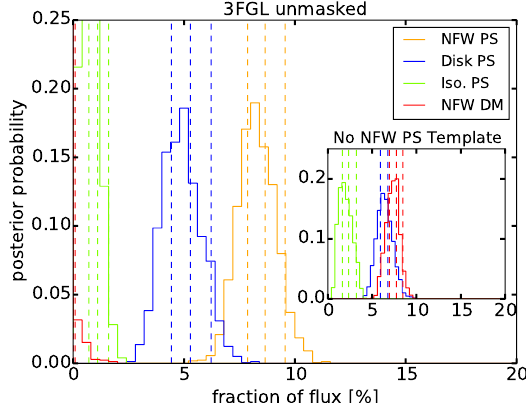
Figure 17: Posteriors for the flux fraction within 10 ◦ of the Galactic Center with | b | ≥ 2 ◦ arising from the separate point source components, with known point sources unmasked. The inset shows the result of removing the NFW PS template from the fit. Dashed vertical lines indicate the 16 th , 50 th , and 84 th percentiles. Re- produced from Ref. [ 235 ]